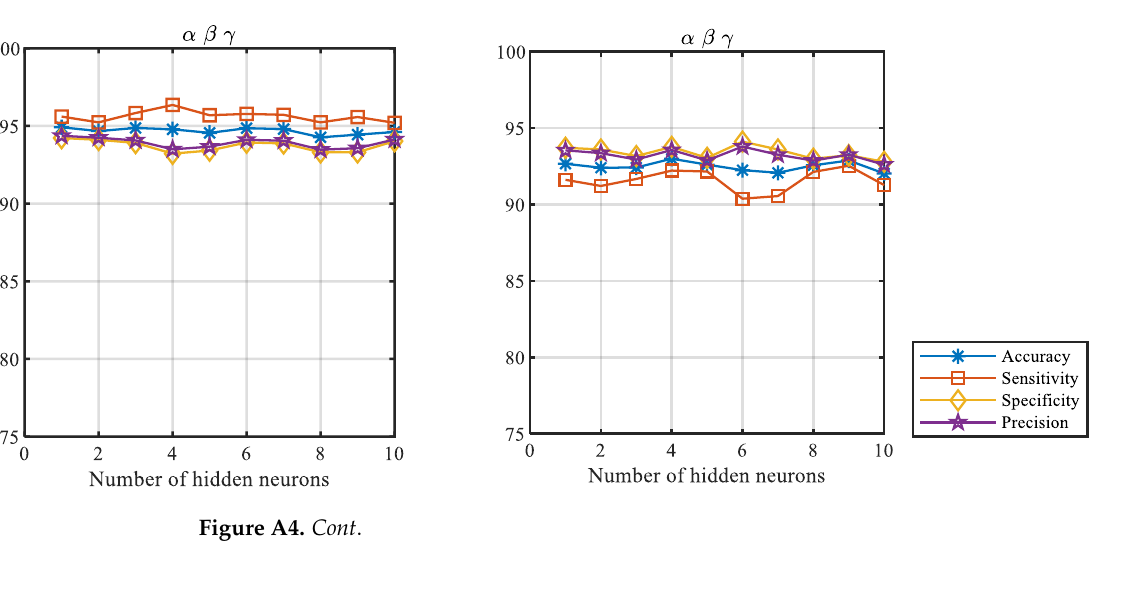
Figure A4. Network classification measures for selected combinations of many frequency bands, where the training and testing feature set vectors were separated by different parts of the same sessions ( left , the first scenario) and different sessions ( right , the second scenario). References 1.